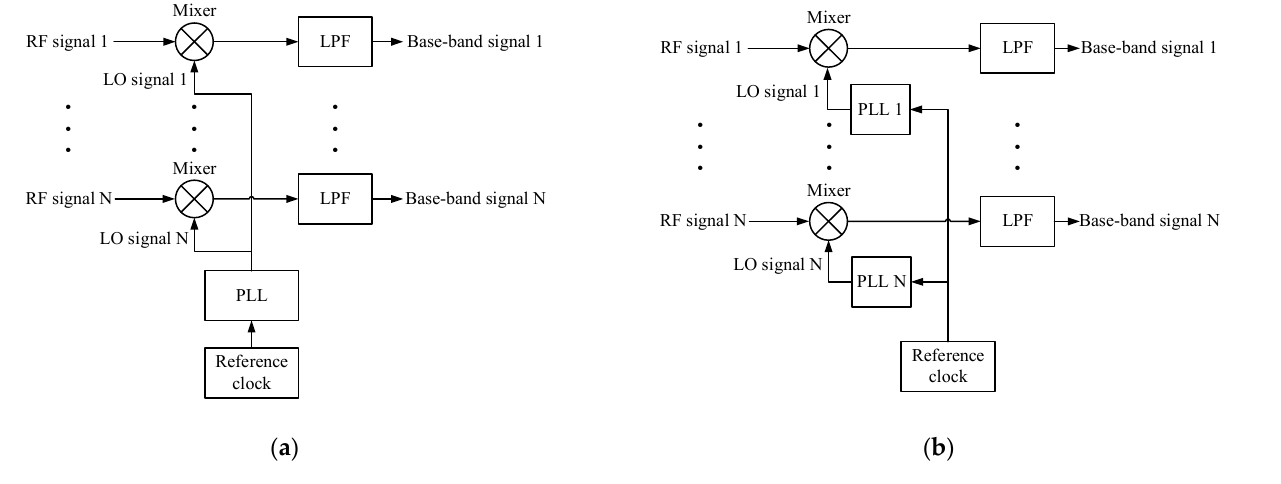
Figure 1. Typical down-conversion circuit structures: ( a ) with a common local oscillator; ( b ) with a common reference